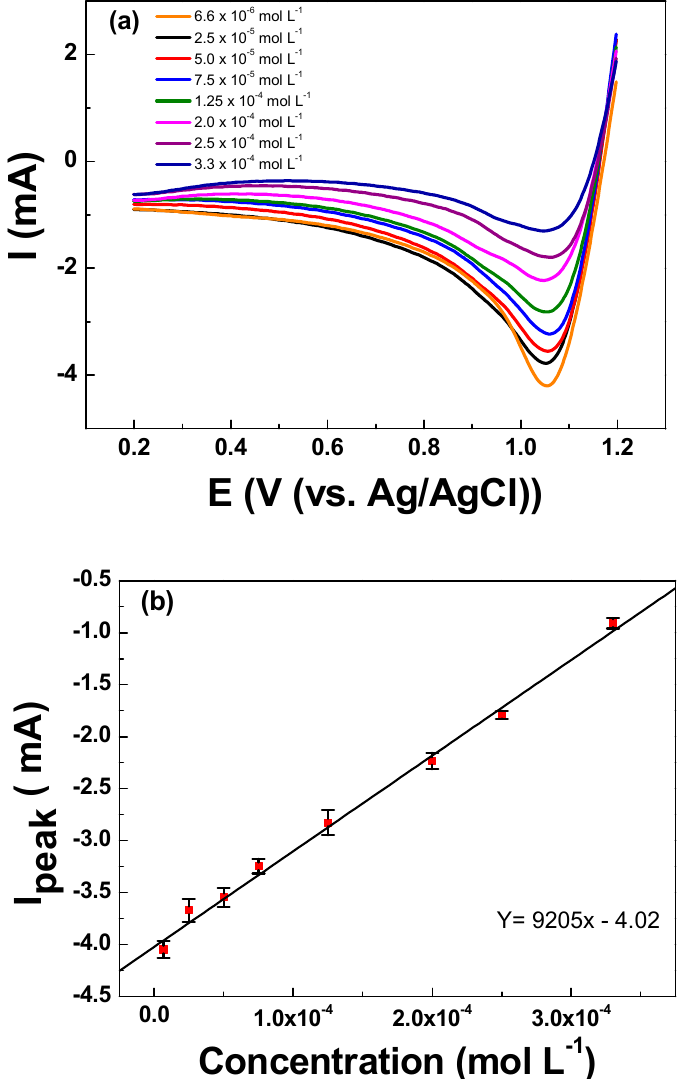
Figure 5. ( a ) Linear sweep voltammetry curves registered for increasing concentrations of urea ranging from 6.66 × 10 -6 to 3.33 × 10 -4 mol L -1 in KCl 0.10 mol L -1 . ( b ) Linear relationship between the registered I peak vs. the concentration of urea showing excellent fitting for a linear relationship. LSV curves were registered on the Ti/RuO 2 -TiO 2 -SnO 2 (50:40:10 atom. %) working electrode at υ = 50 mV s -1 scan rate after holding 1.2 V vs. Ag/AgCl for 60 s as analytical preconditioning. Table 5. Comparison between performance characteristics of the proposed method and other studies described in the literature for urea determination.